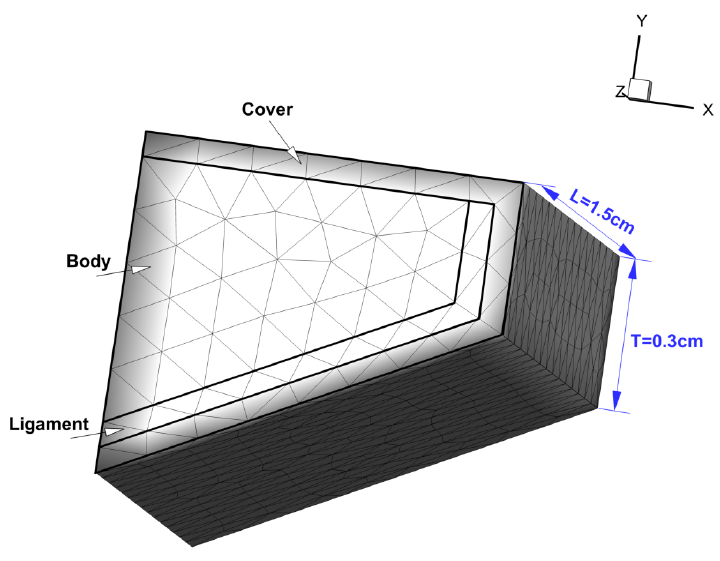
Figure 8. Prephonatory geometry of the vocal fold (left